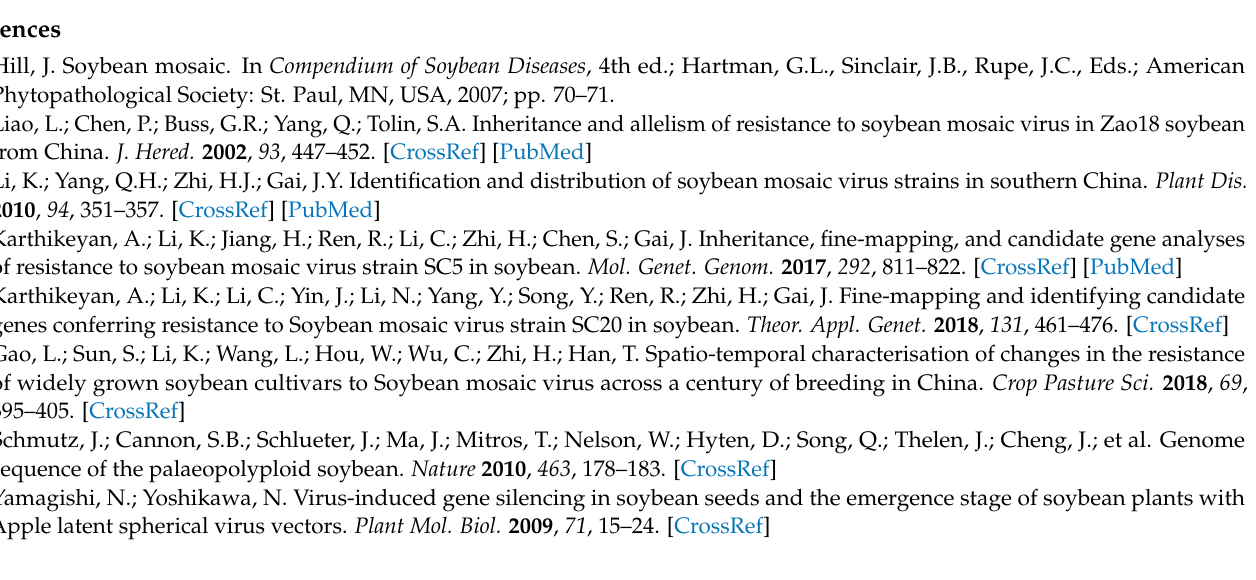
Figure S2: Gene ontology classification of proteins interacted with GmFNR, Table S1: 71 proteins interacting with